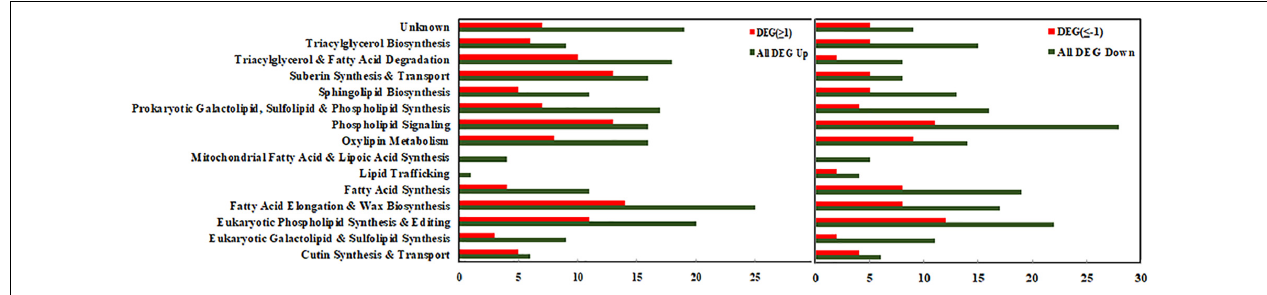
FIGURE 4 | Functional categorization of lipid-related genes from maize roots transcriptome under cold stress (5 ◦ C). Left columns represent up-regulated genes, and right columns represent down-regulated genes. In each category, the green colored column represents the total differentially expressed genes (DEGs), and the red colored column represents the significantly differentially expressed genes (DEGs with Log2FC ≥ 1 or ≤ –1). The number of the genes in each category were displayed on the x -axis (the ones on the upper x -axis indicate the DEGs with Log2FC ≥ 1 or ≤ –1).